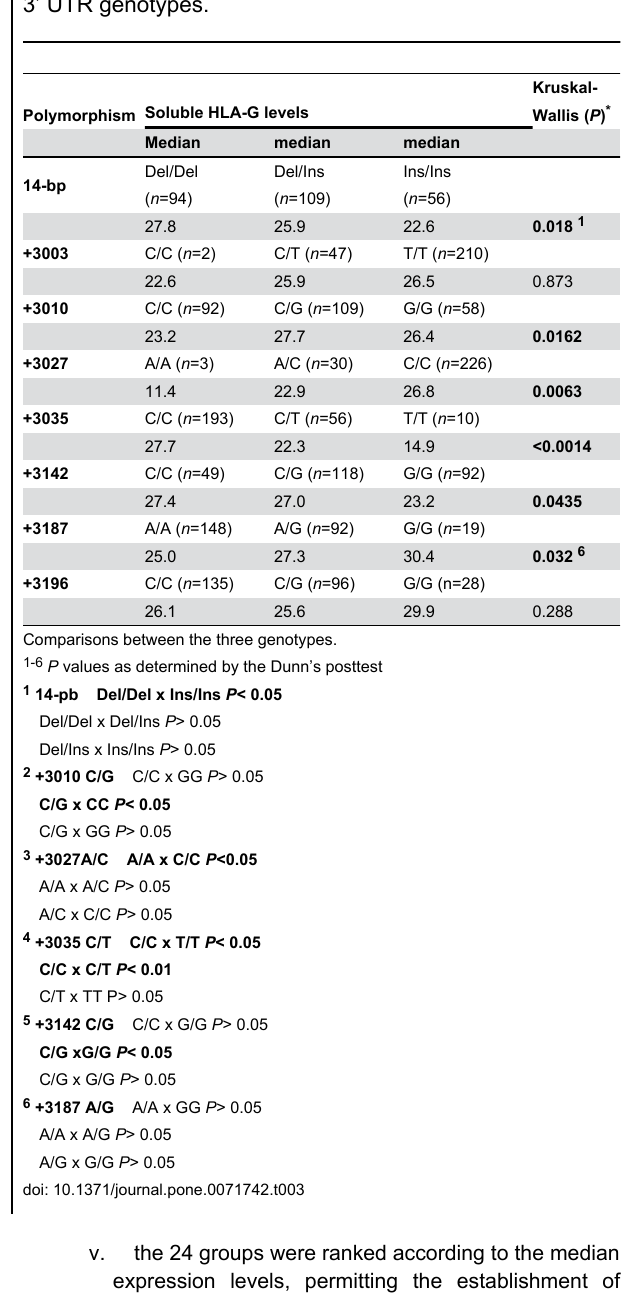
Table 3. Comparisons of plasma soluble HLA-G levels (ng/mL) in the whole group of healthy individuals (Brazilian plus French individuals), stratified according to the HLA-G 3’ UTR genotypes.